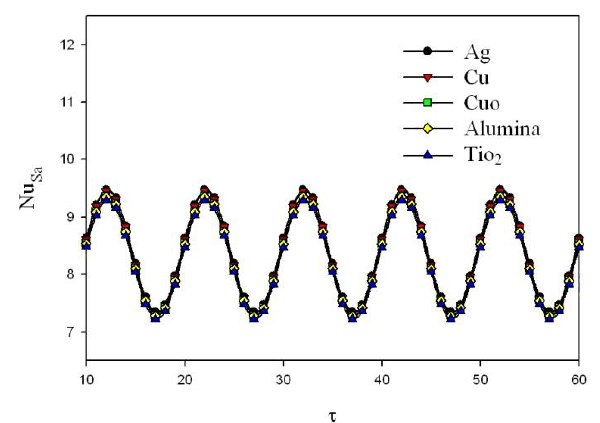
Fig. 11. Temporal Variation of space averaged Nusselt number for different thermo-physical properties of water and nanoparticles at A =0.1, St=0.1, Re=100 and 0 0.02 φ = .